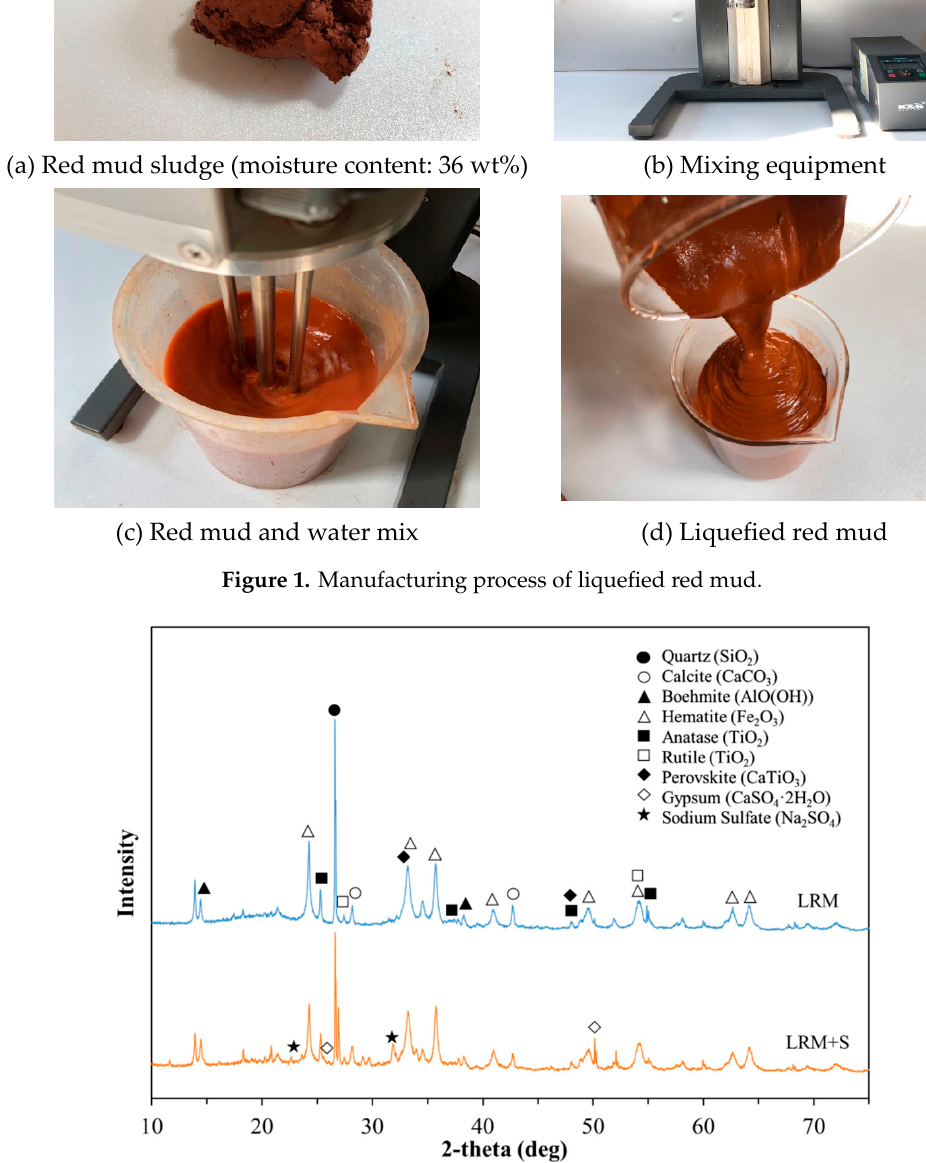
Figure 2. XRD patterns of LRM and LRM + S.